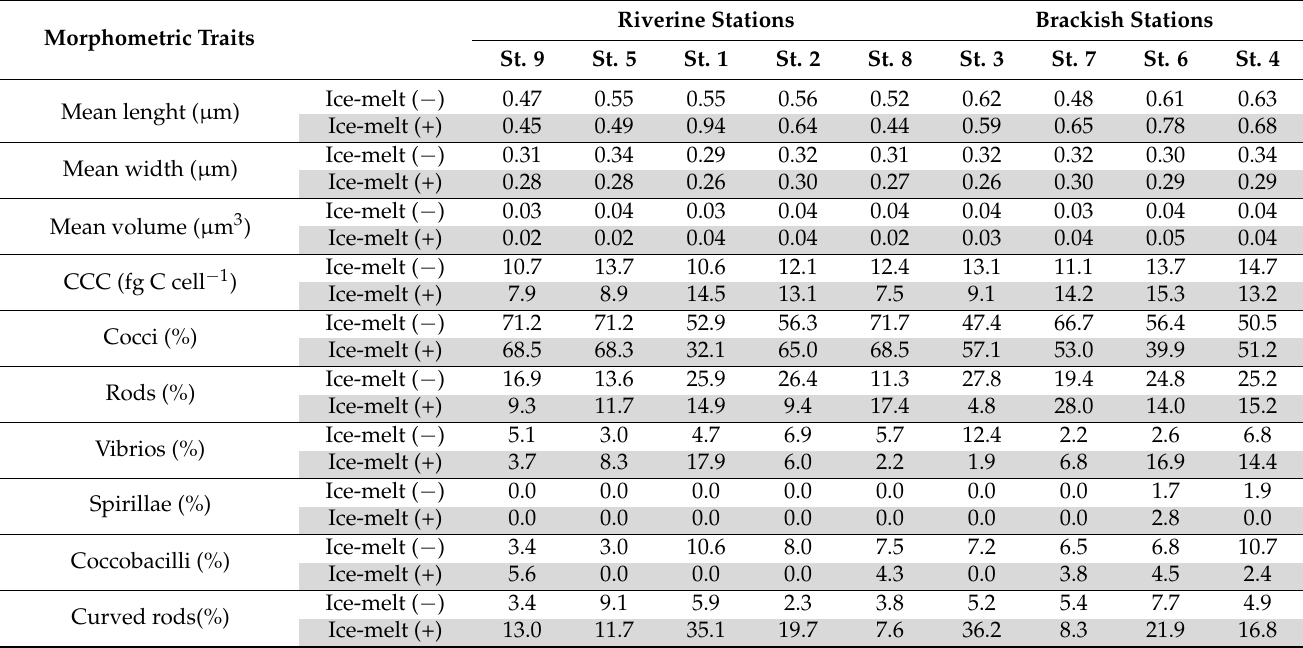
Table 4. Morphometric and morphological traits of prokaryotic cells in water samples collected in May (Ice-Melt ( − )) and July (Ice-Melt (+)) 2014 along the Pasvik River. Morphometric Traits